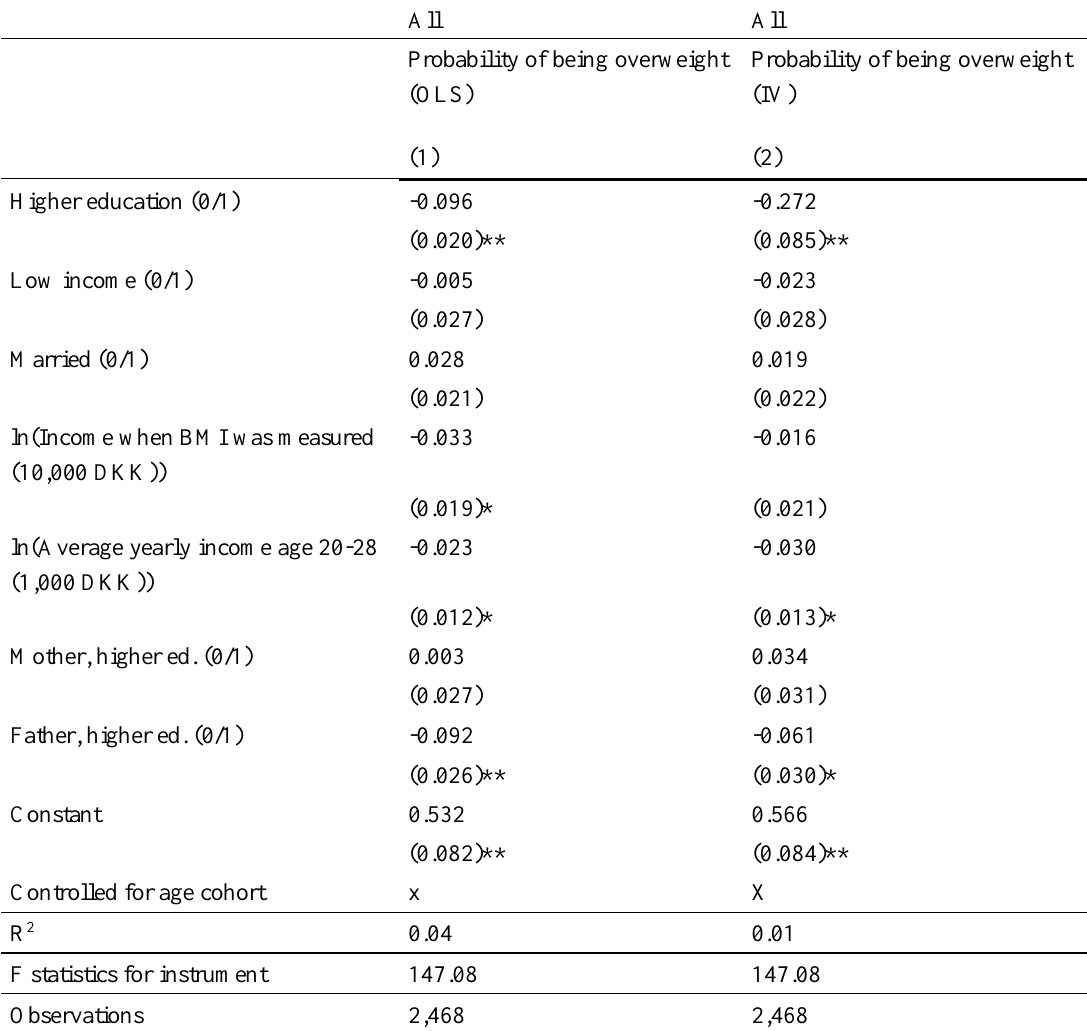
Body weight and higher education among all women and by